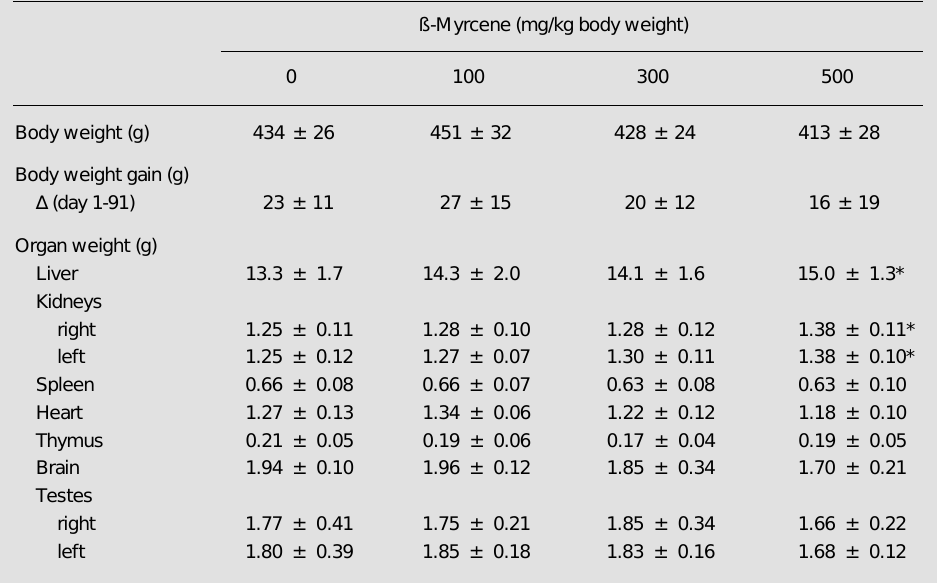
Table 1 - Body weight gain and organ weight changes in male rats treated orally with ß-myrcene (0, 100, 300 and 500 mg/kg body weight) for 91 days prior to